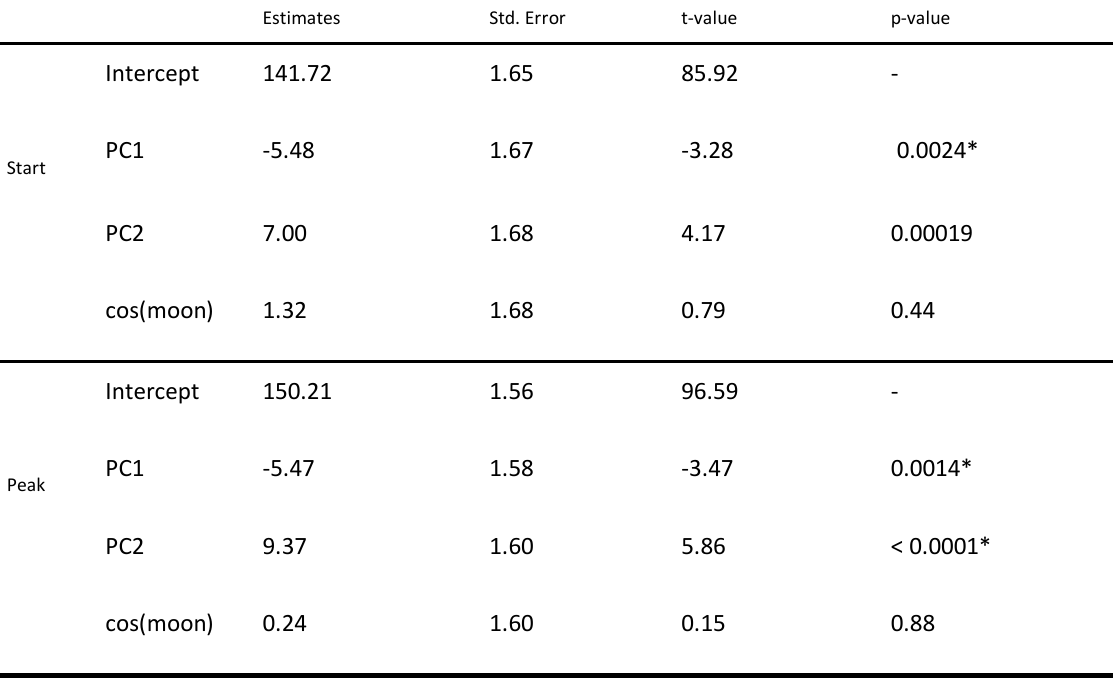
Table 2. Summary of the linear regression on the start and peak of the breeding season. For each variable we show the estimate, its standard error, and the t-value and p-value associated with it. Asterisks next to the p-value show significance at the 0.05 level. No p-values are provided for the intercept because this test is not of biological